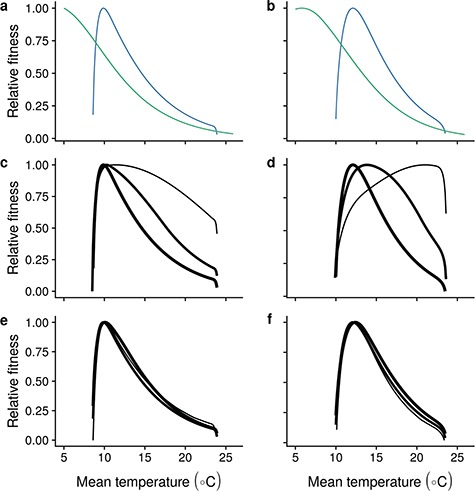
Fitness (\documentclass[12pt]{minimal}
\usepackage{amsmath}
\usepackage{wasysym}
\usepackage{amsfonts}
\usepackage{amssymb}
\usepackage{amsbsy}
\usepackage{upgreek}
\usepackage{mathrsfs}
\setlength{\oddsidemargin}{-69pt}
\begin{document}
}{}${R}_0$\end{document}), relative to maximum fitness within (a and b) oxygen limited (blue) and non-oxygen limited (teal) for slow (left column) and fast strategy (right column) species at the assumed MRN and default parameters, and (c and d) changes in relative fitness with respect to temperature resulting from decreasing levels of activity cost symbolized by decreasing line width, and (e and f) changes in relative fitness with respect to temperature as a function of increasing food availability (increasing line width).